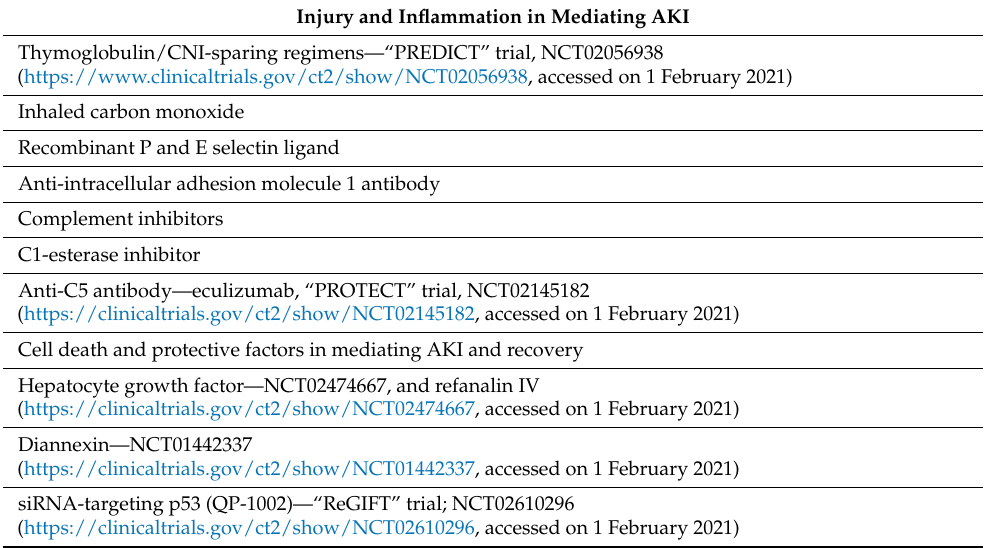
Table 2. Newer recipient-oriented therapies for